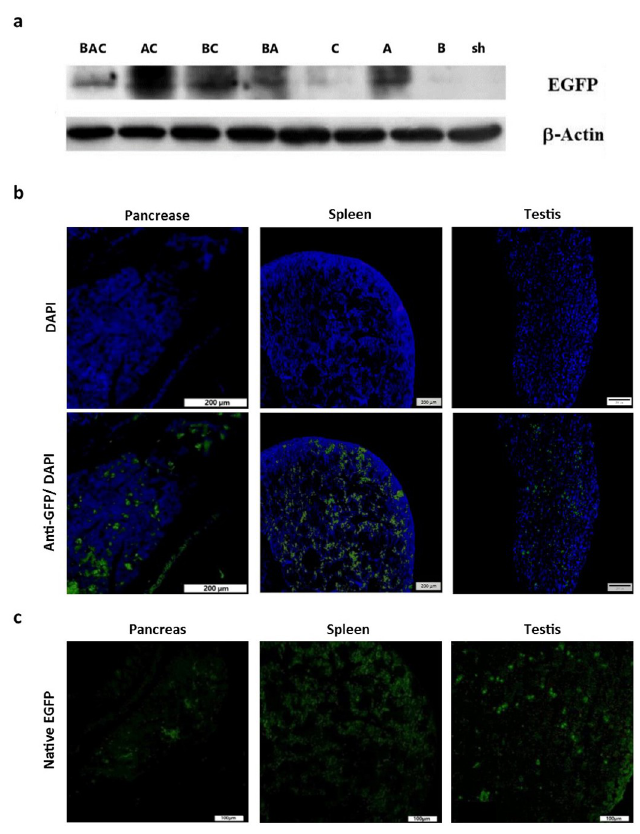
Fig 4. Detection of EGFP protein using Western blotting and fluorescence microscopy in G 0 chickens. (a) Western blotting analysis of the testicular protein extracts from the seven vector-injected groups and the sham group. β -actin was used as the loading control. (b) The mosaic expression of EGFP was confirmed in the pancreas, spleen and testis tissue sections from a G 0 chick in group C by use of Alexa-Fluor488 conjugated anti-GFP antibody stained on paraffin- embedded tissues. (c) Direct detection of EGFP fluorescence in OCT-embedded tissues from a G 0 chick in group C.